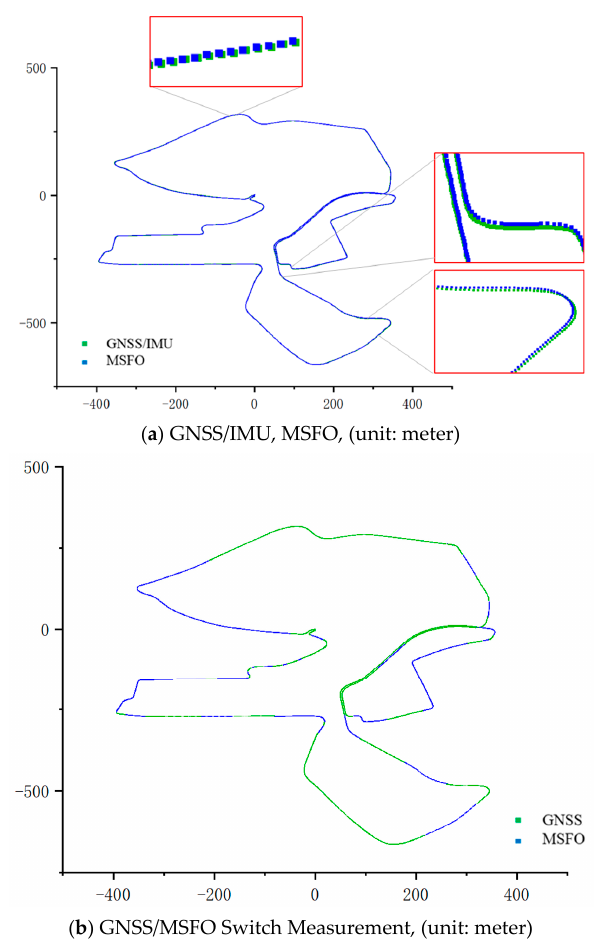
Figure 15b. Figure 15b.